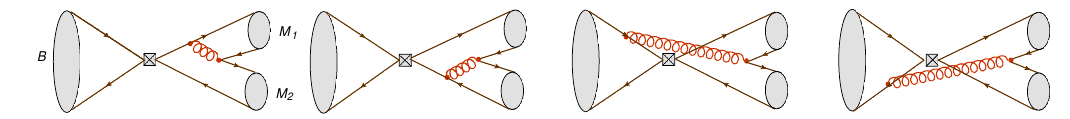
Figure 5 . Annihilation topologies contributing to the decay process B ! M 1 M 2